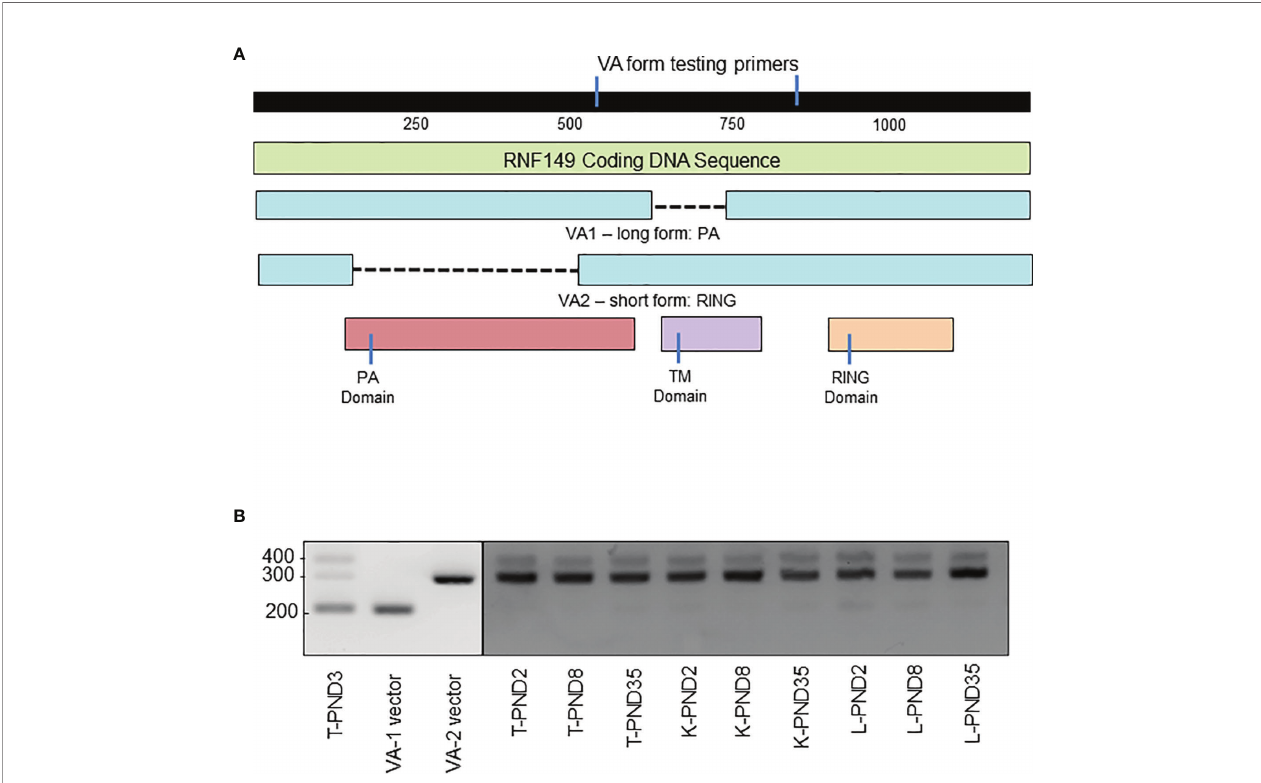
FIGURE 6 | PCR analysis of RNF149 variant forms in rat testes, kidney, and liver at various ages. (A) Gene map of RNF149 coding sequence. Green bar represents total RNF149 coding sequence that includes the PA domain (red), transmembrane TM domain (purple), and RING domain (orange). Blue bars represent two variant forms of RNF149 found in the rat. (B) PCR products of RNF149 in PND3 rat testes, and VA1 and VA2 plasmids compared to kidney and liver at various ages. T, testis; K, kidney; L,